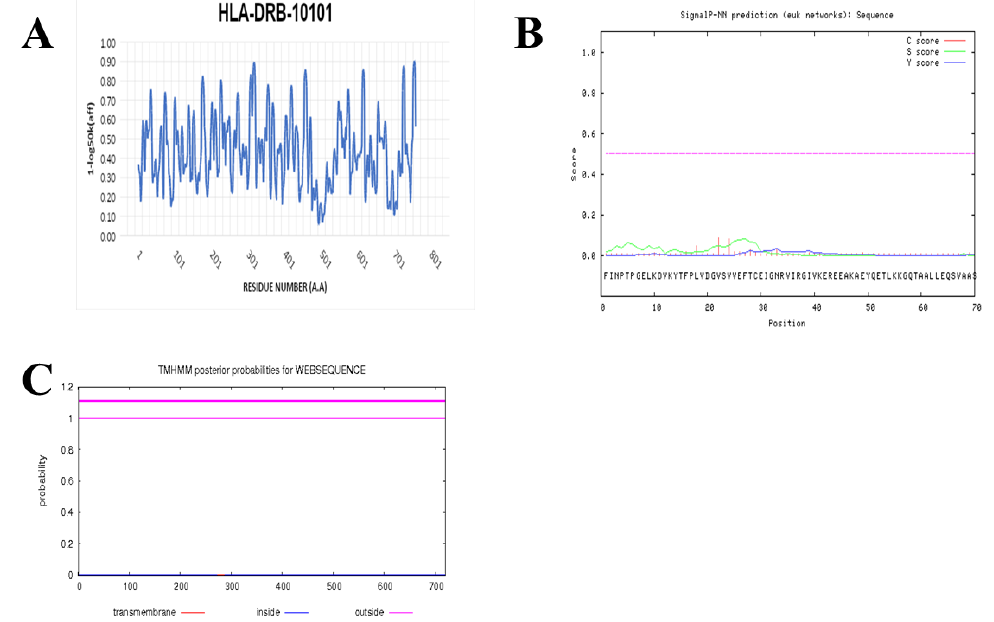
Figure 1. Interaction analysis of interalpha trypsin (PADG_06178) by integrating different algorithms. ( A ). Signal peptide prediction (signal peptide). ( B ). Prediction of transmembrane regions (TMHMM). ( C ). Prediction of epitopic regions for MHC II (NetMHCII).